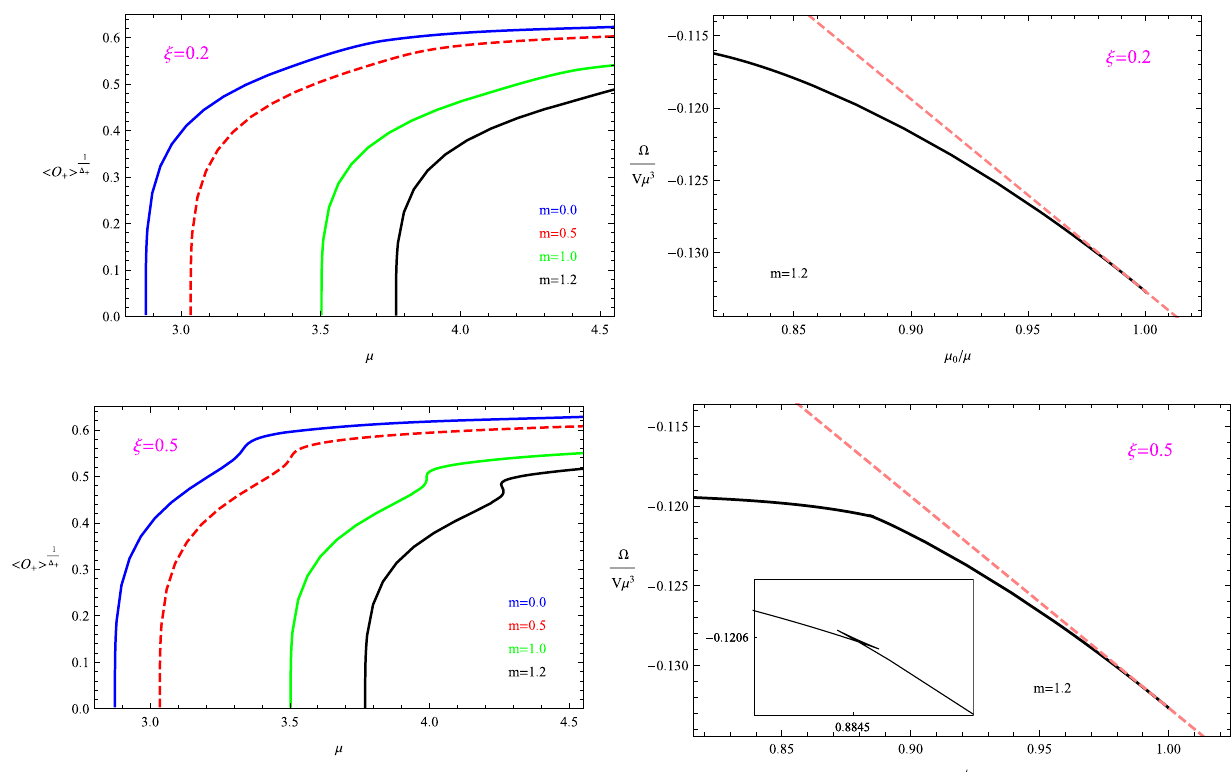
m = 0 . 0 (blue), 0 . 5 (red dotted), 1 . 0 (green) and 1 . 2 (black), respec- tively. For the right two panels, the two lines in each panel correspond to the superconducting phase (black) and normal phase (pink dotted) in the case of m = 1 . 2,